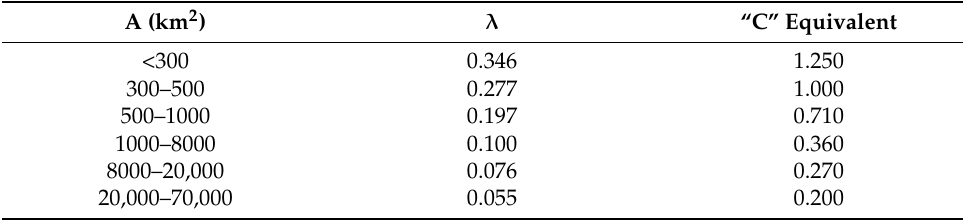
Table A3. Giandotti reduction coefficients (Source: [31]).